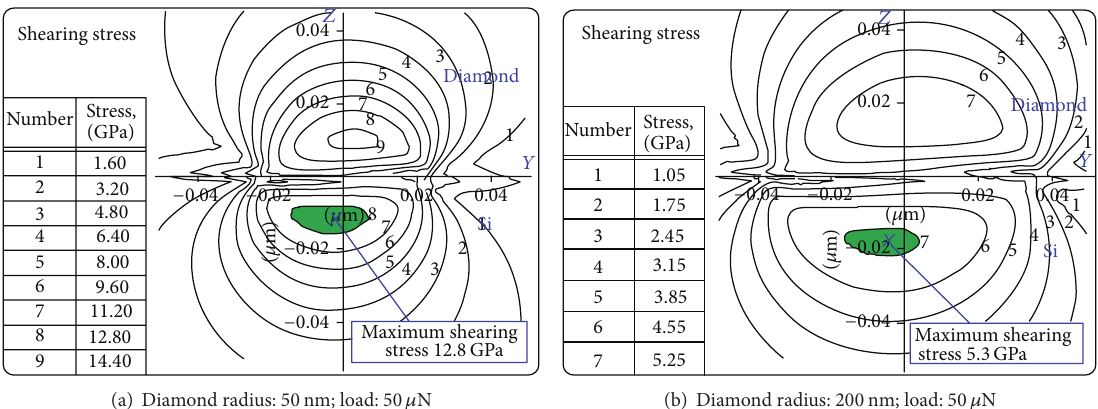
Number Stress, (GPa)